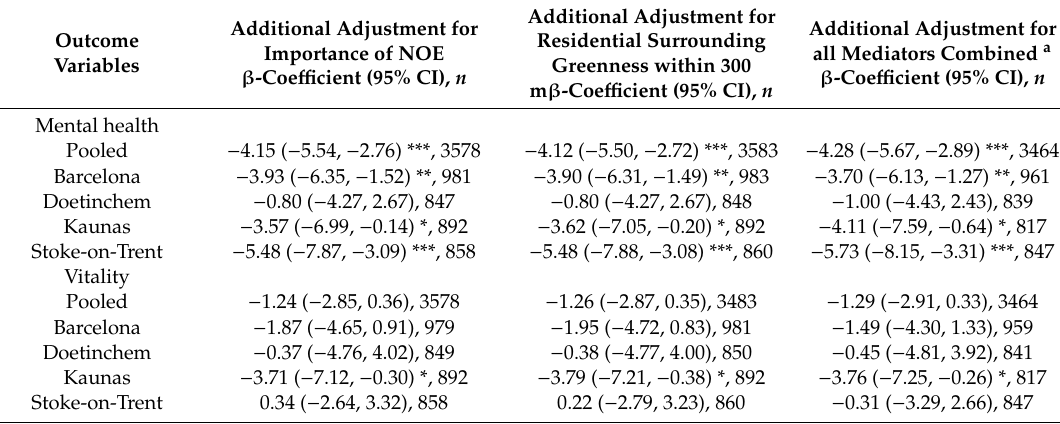
Table 10. Mixed e ff ects regression of childhood NOE exposure (low levels vs. high levels) on mental health and vitality (0–100 scales; higher is better mental health / vitality) with additional adjustments for importance of NOE, residential surrounding greenness within 300 m, and all mediators